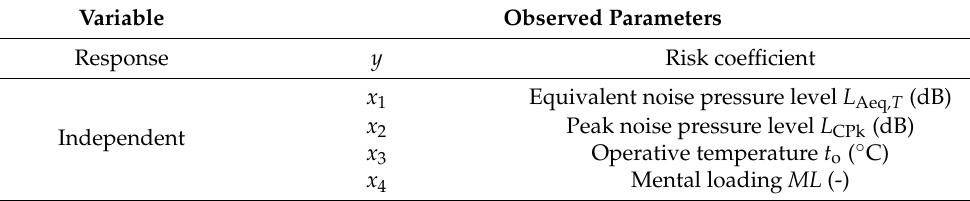
Table 1. Independent and response